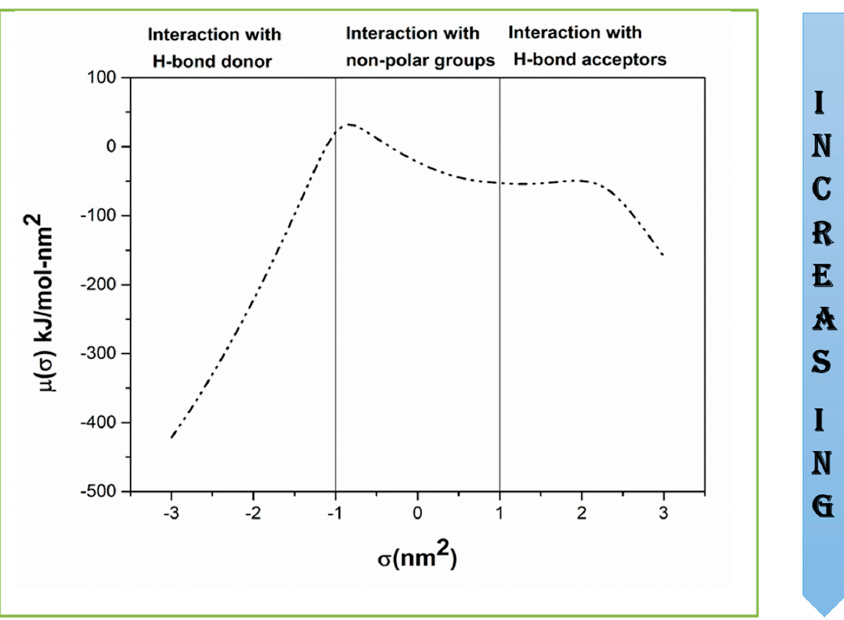
Figure 2. σ -potential of Ibf evaluated using COMSO-RS .